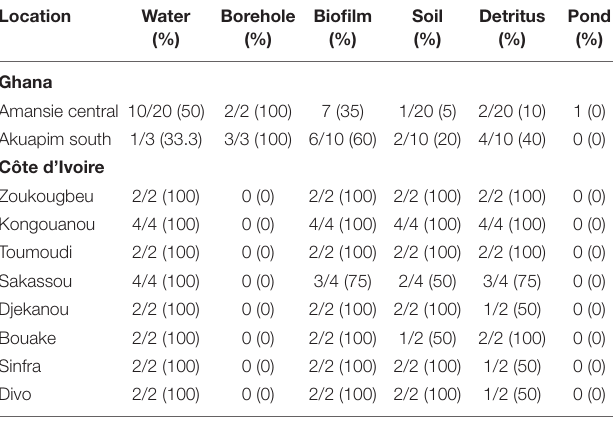
TABLE 2B | M. ulcerans DNA positivity from environmental